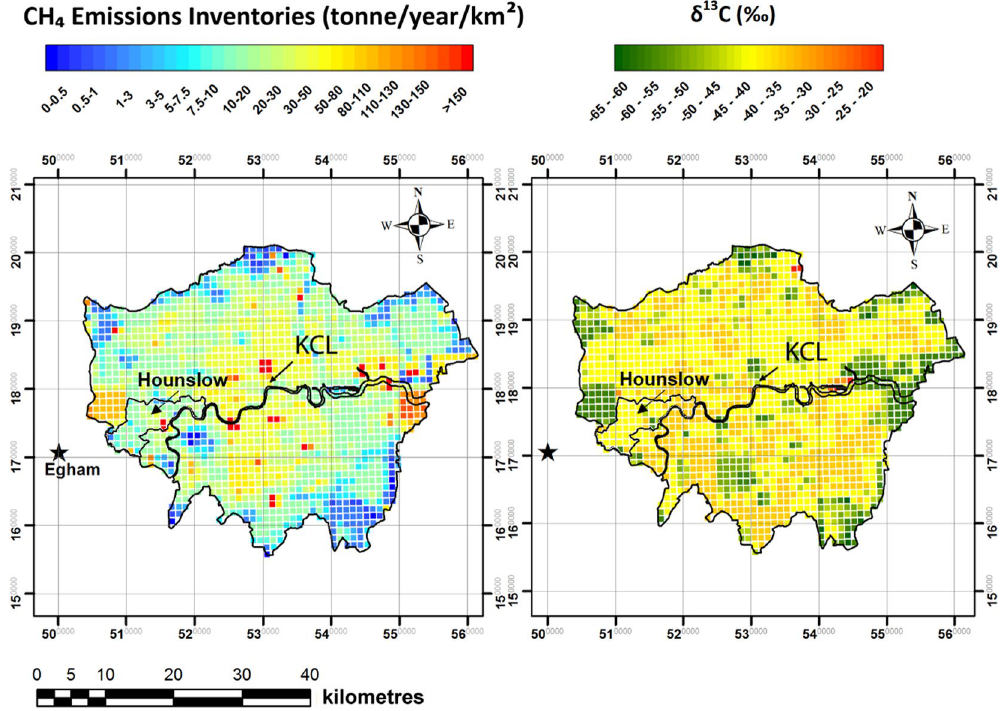
Figure 1. Emission ( a ) and isotopic ( b ) map for London based on 2013 NAEI methane inventories. Emissions are provided in tonne/year/km 2 (~3.2 · 10 − 11 kg/s/m 2 ). The star indicates Egham, where the Royal Holloway University of London is located. King’s College London (KCL) and the borough of Hounslow are indicated. Most of the hotspots are associated with 13 C-depleted areas. The large area affected by high emissions on the east side of the London region includes biogenic methane sources, such as landfill sites and waste-water treatment plants. The map was generated using ArcMap